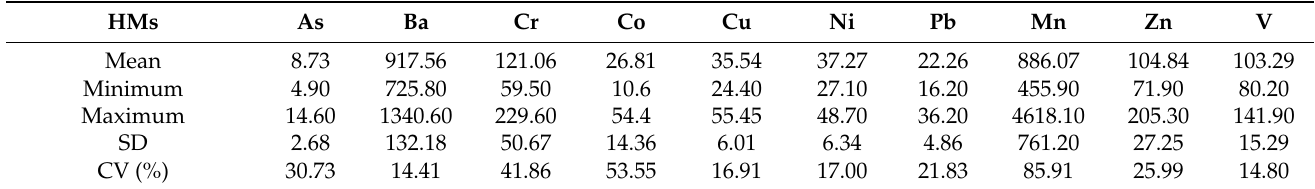
Table 1. Contents (mg/kg) of HMs in sediments of the Mianyang section of the Fujiang River and other reported rivers in China, as well as the background values of the Sichuan